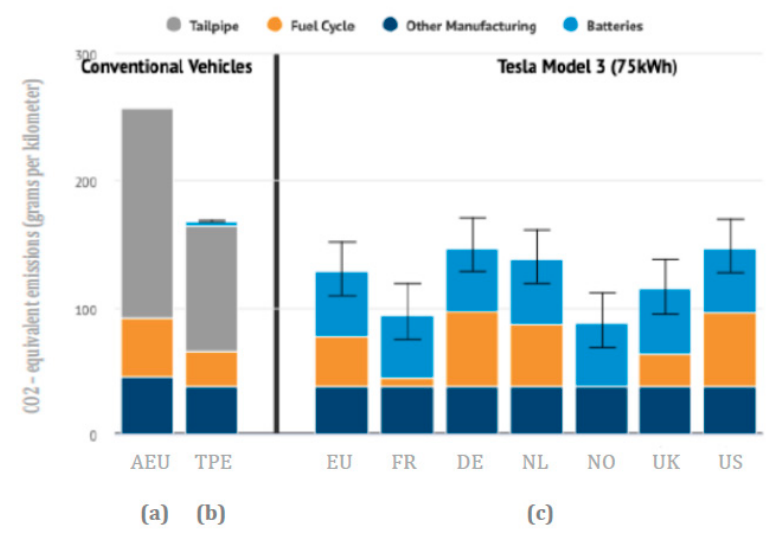
Figure 3. Comparison of the calculated life cycle emissions over 150,000 km of ( a ) a conventional gasoline vehicle (average European car), ( b ) the most efficient on the road hybrid electric vehicle (the Toyota Prius Eco) and ( c ) the Tesla Model 3 with 75 kWh battery storage powered with the respective average electricity from a number of European counties and the USA—error bars indicate the uncertainty of the emissions of BEV batteries (reproduced from Carbon Brief [48] and an ICCT study